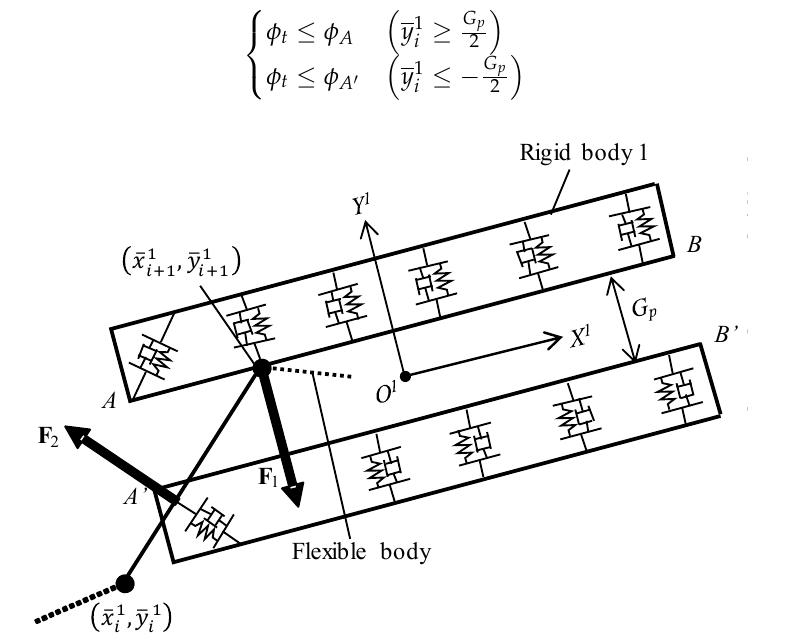
Figure 4. Flexible body element drawn into rigid body 1.